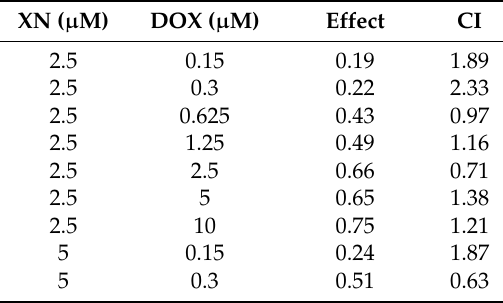
Table 2. Result of isobolographic analysis showing CI of DOX in the presence of different concentrations of XN in MCF-7 cells. The CI values were calculated by